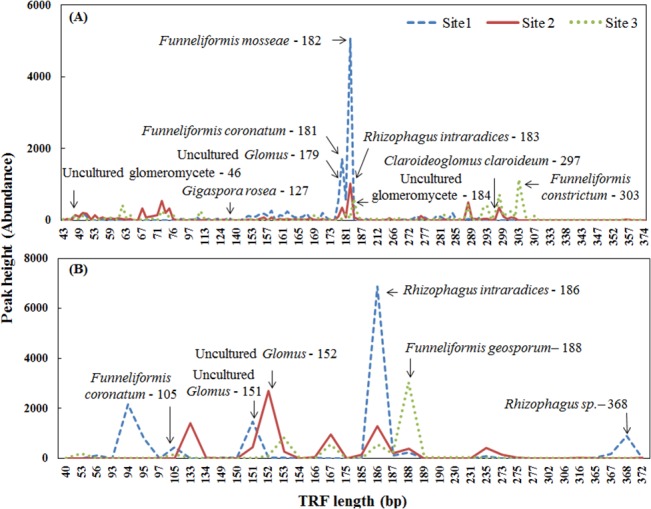
Peak abundance of Terminal Restriction Fragments (T-RFs) and AMF ribotype corresponds to fragment size.(A) AluI, (B) MboI digestion.